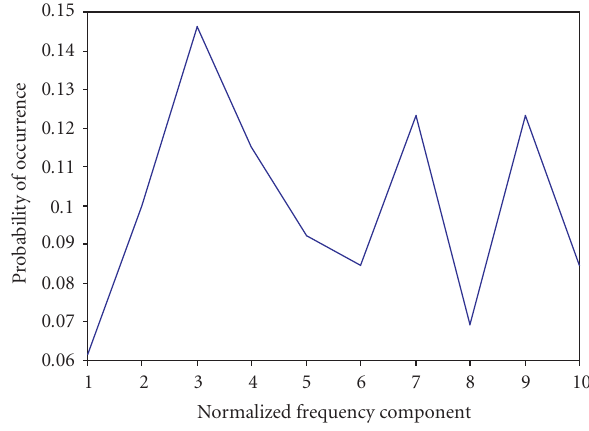
Figure 5: Histogram peak of Subsystem2.